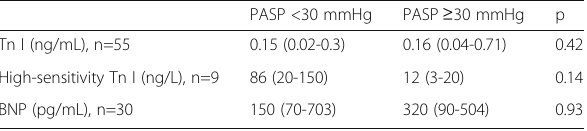
Table 2 (abstract 000018). Relationship between PASP assessed by TTE and cardiac